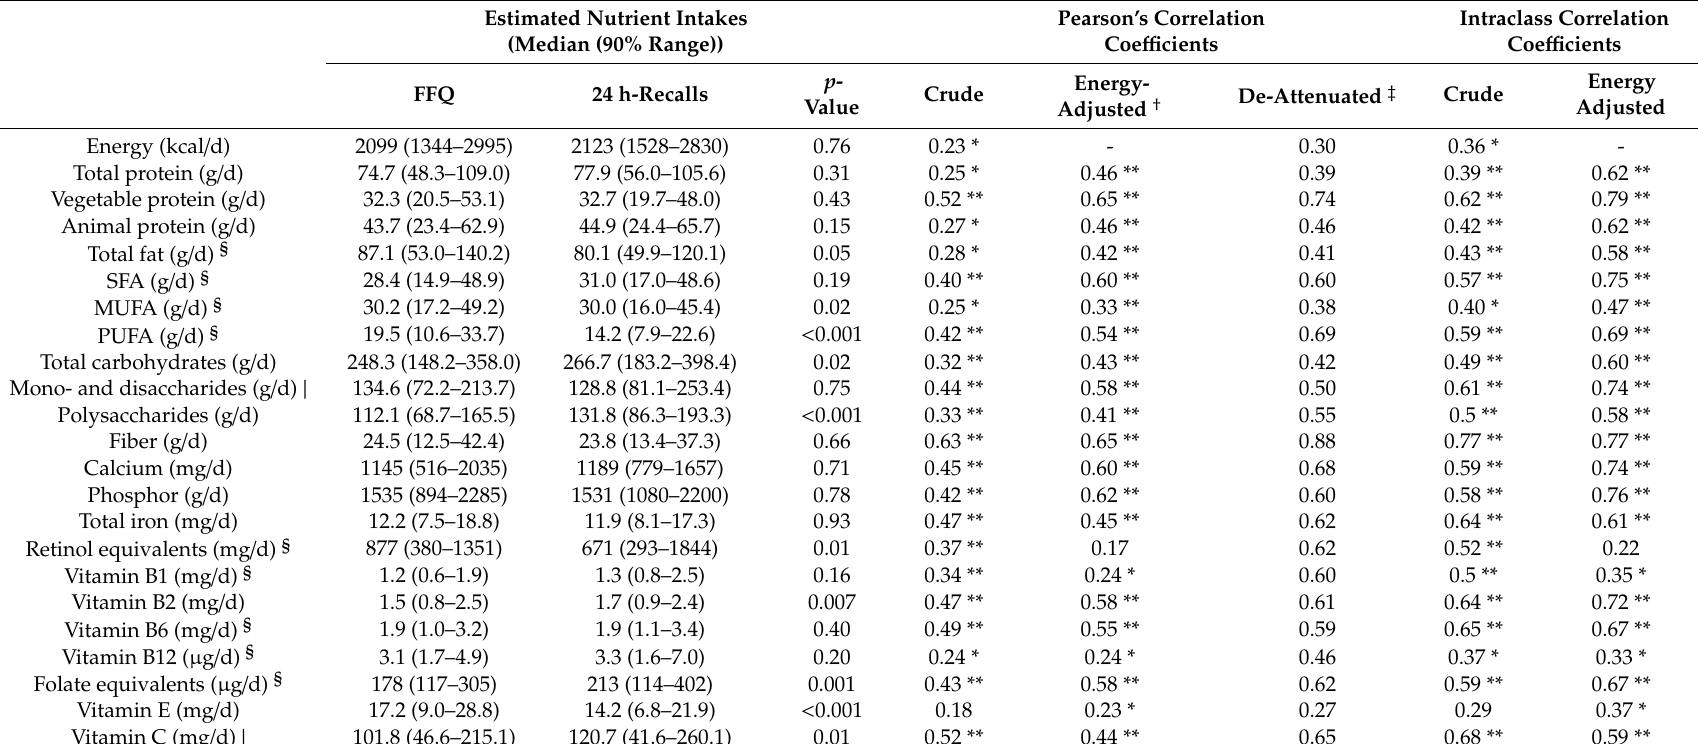
Table 2. Energy and nutrient intakes as estimated with the FFQ and repeated 24